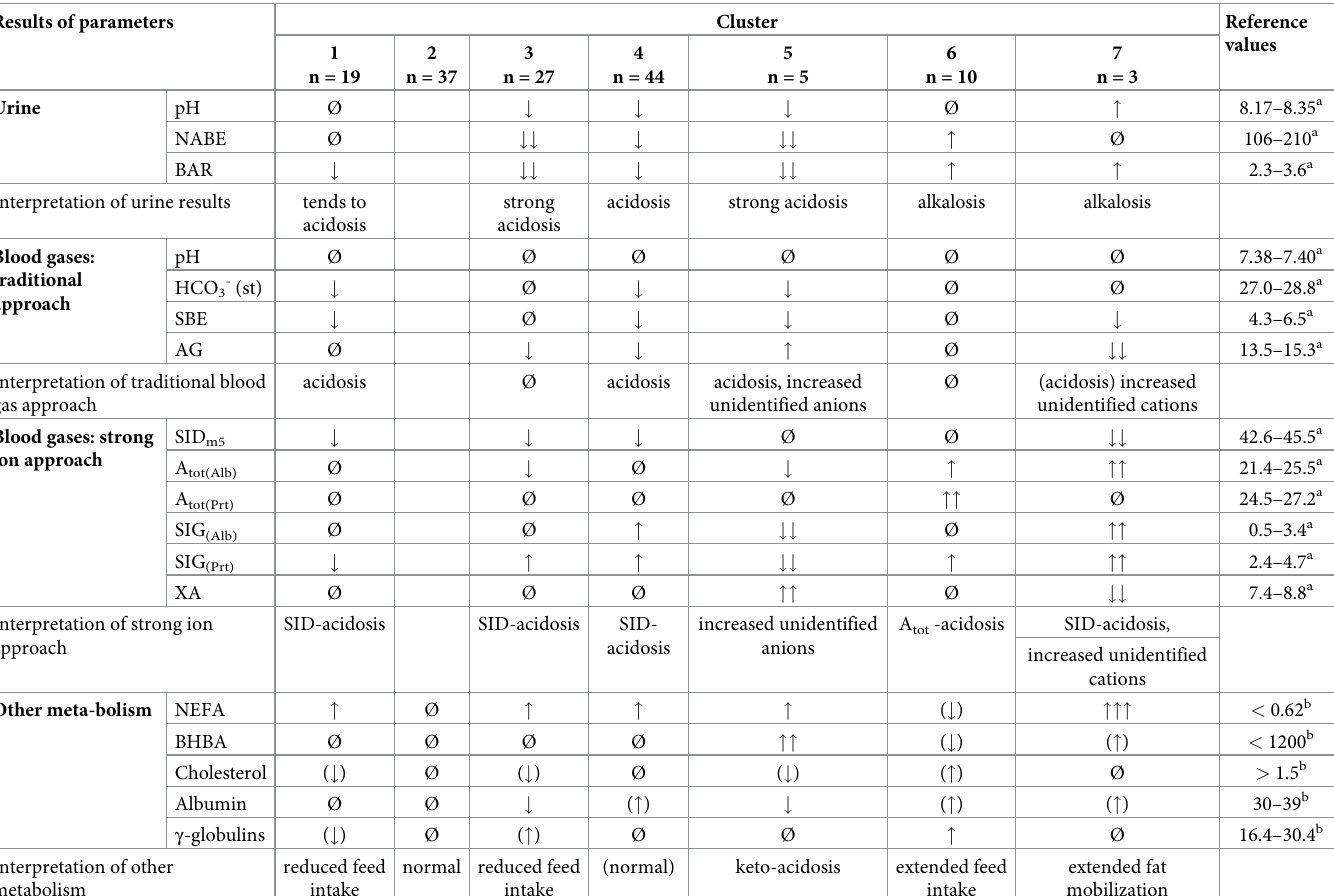
Table 2. Main results of different approaches to evaluate acid base equilibrium in the generated